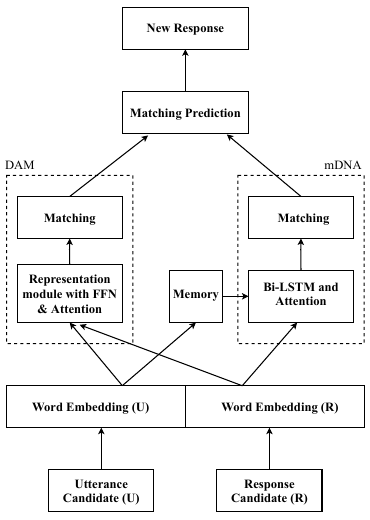
Figure 1. Operational flow of DAM augmented with